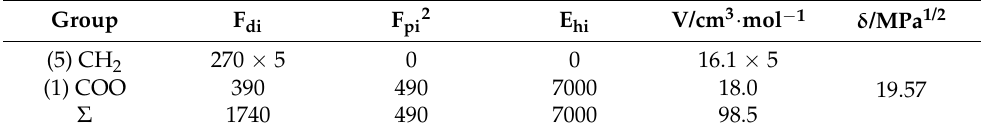
Table 3. Calculation of solubility parameter for